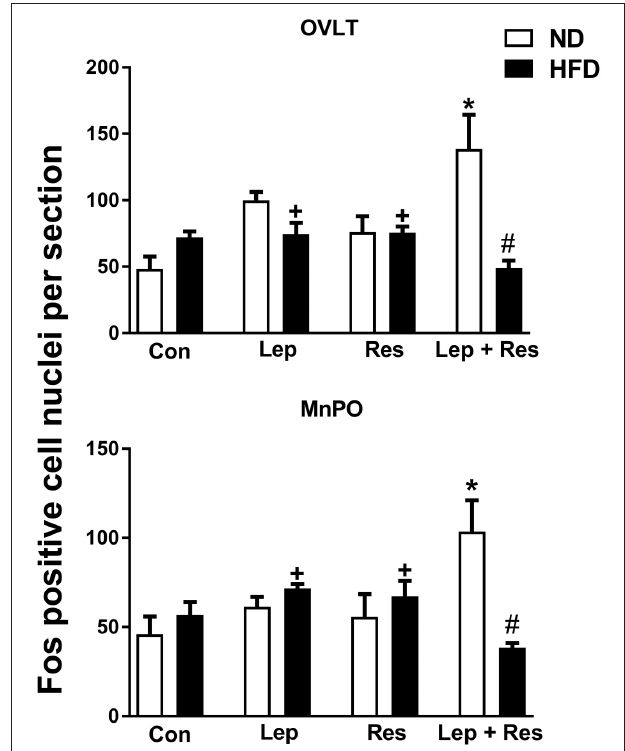
FIGURE 1 | Numbers of Fos-positive cell nuclei per section in the organum vasculosum of the lamina terminalis (OVLT) and median preoptic nucleus (MnPO) from rats fed a normal chow (ND) and a high fat diet (HFD) administered intracerebroventricular saline (control, n = 6 ND, n = 4 HFD; 5 µ l), leptin ( n = 5 ND, n = 5 HFD; 7 µ g in 5 µ l), resistin ( n = 4 ND, n = 4 HFD; 7 µ g in 5 µ l) or leptin combined with resistin ( n = 5 ND, n = 6 HFD). * P < 0.005 and P < 0.05 compared with control in the OVLT and MnPO, respectively. # P < 0.005 HFD compared to ND in the OVLT and MnPO. + P < 0.05 and P < 0.005 compared with leptin + resistin in the OVLT and MnPO respectively.